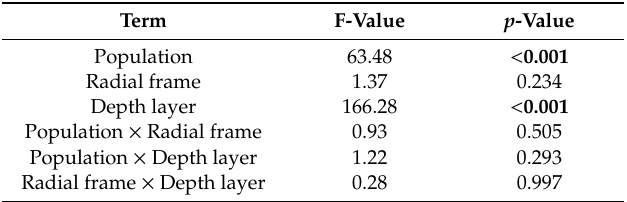
Table 3. Tests of fixed e ff ects (either main e ff ects and interactions) obtained by the normal-based mixed multiway ANOVA method. p -Values significant at 5% are highlighted in bold.